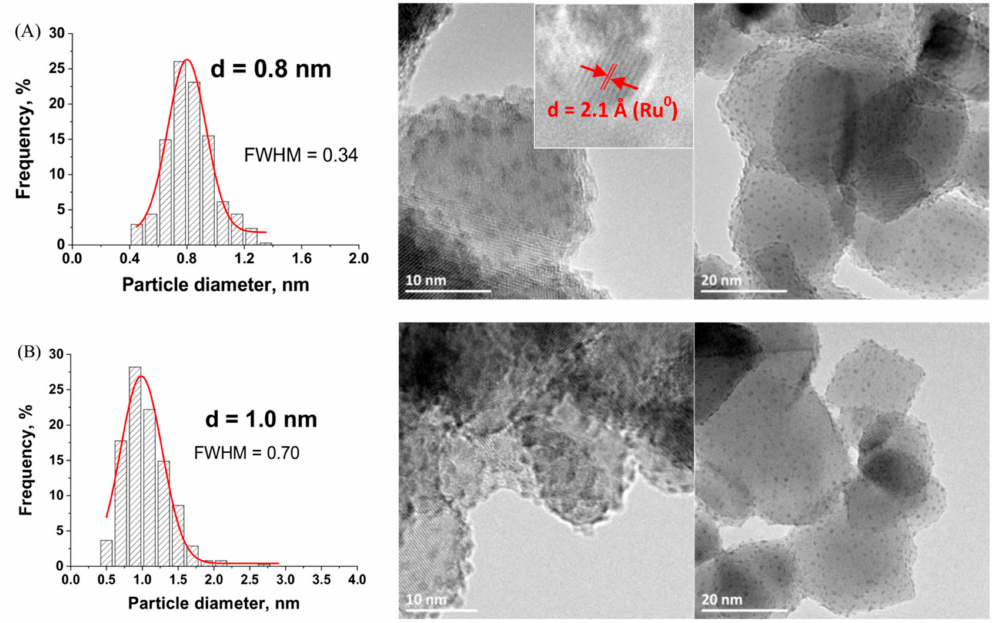
Figure 6. TEM image and the Ru nanoparticle size distribution for the Ru(5wt.%)/TiO 2 -P25 catalysts prepared ( A ) at pH = 8,0 with the measured interplane distance of (101) planes of metallic Ru; and ( B ) pH =